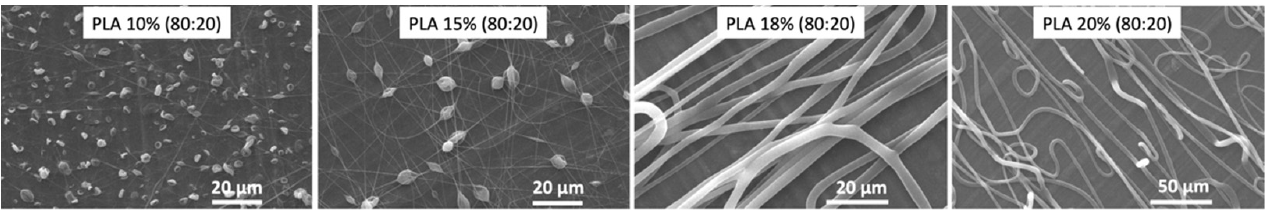
Figure 2. Scanning electron microscope (SEM) images corresponding to polylactic acid (PLA) fibers obtained with different PLA concentration (10, 15, 18 and 20 wt.%) and fixed solvent system (80:20 CHCl 3 :DMF) and electrospinning parameters (16 kV, feeding rate of 1.0 mL/h and rotor velocity of 1300 rpm). Table 2. Viscosity of the different PLA solutions tested. Concentration